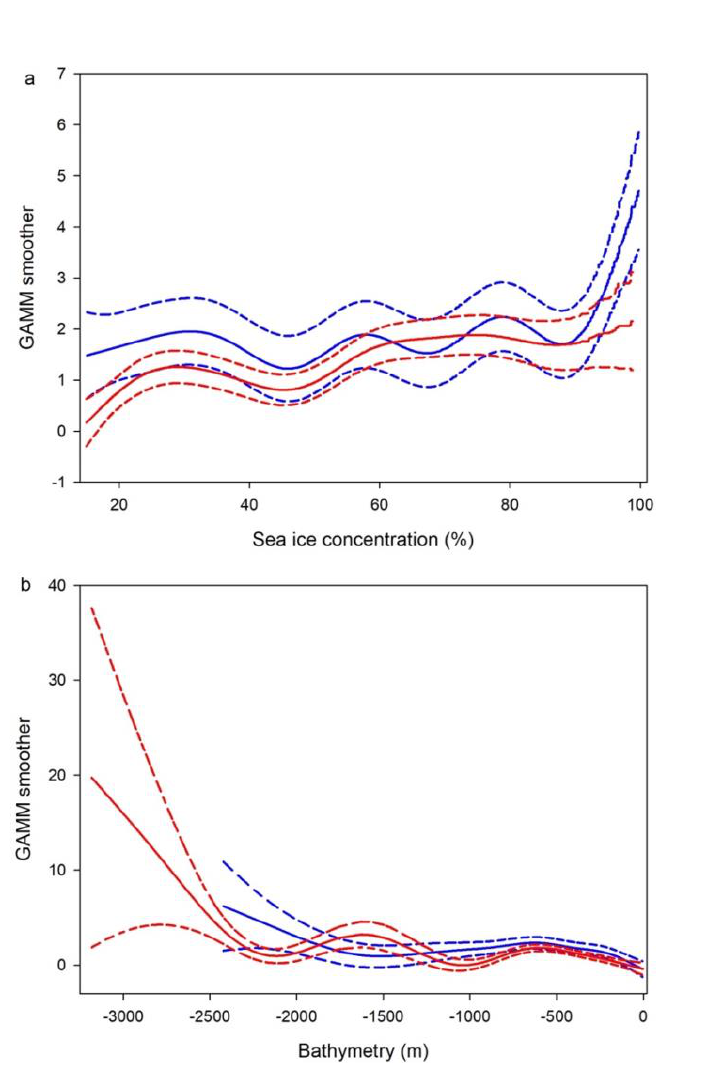
Figure 2. Foraging probability habitat selection functions for (a) sea ice concentration and (b) bathymetry). Plots show the predicted curve from the model (solid line) and 95% confidence intervals (dashed lines) for male (blue) and female (red) snow petrels sampled at Ile des Pétrels, Adélie Land, East Antarctica. GAMM: generalized additive mixed